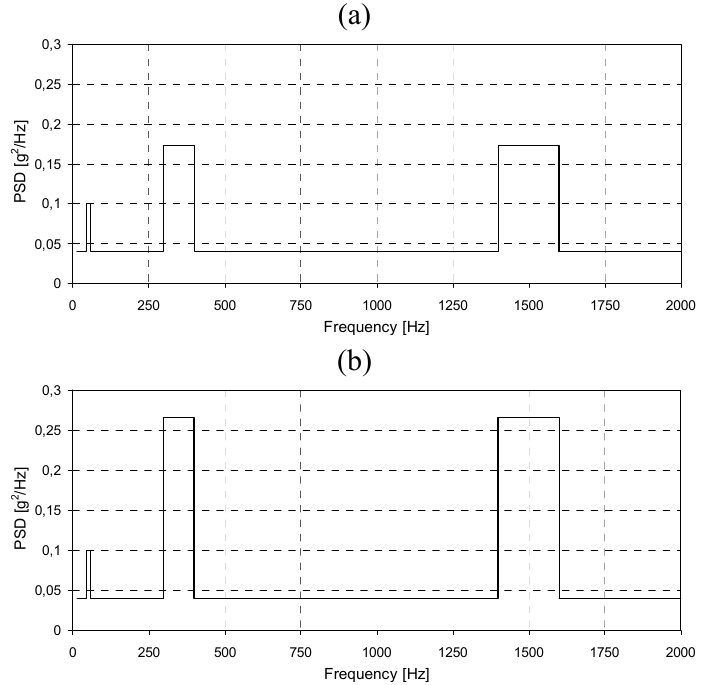
Figure 2. Level of vibration spectra for (a) functional and (b) endurance sections. The narrow band boundaries are 45–60 Hz, 300–400 Hz and 1,400–1,600 Hz in both